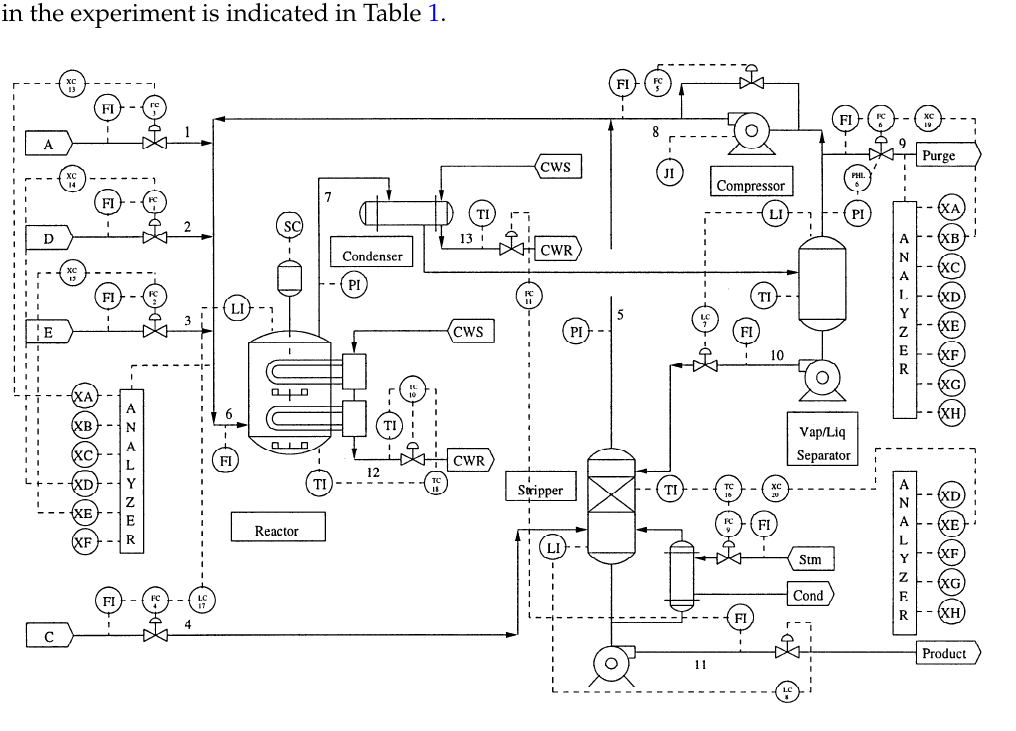
Figure 6. Flow diagram of the Tennessee Eastman process (TEP). Table 1. Description of fault.